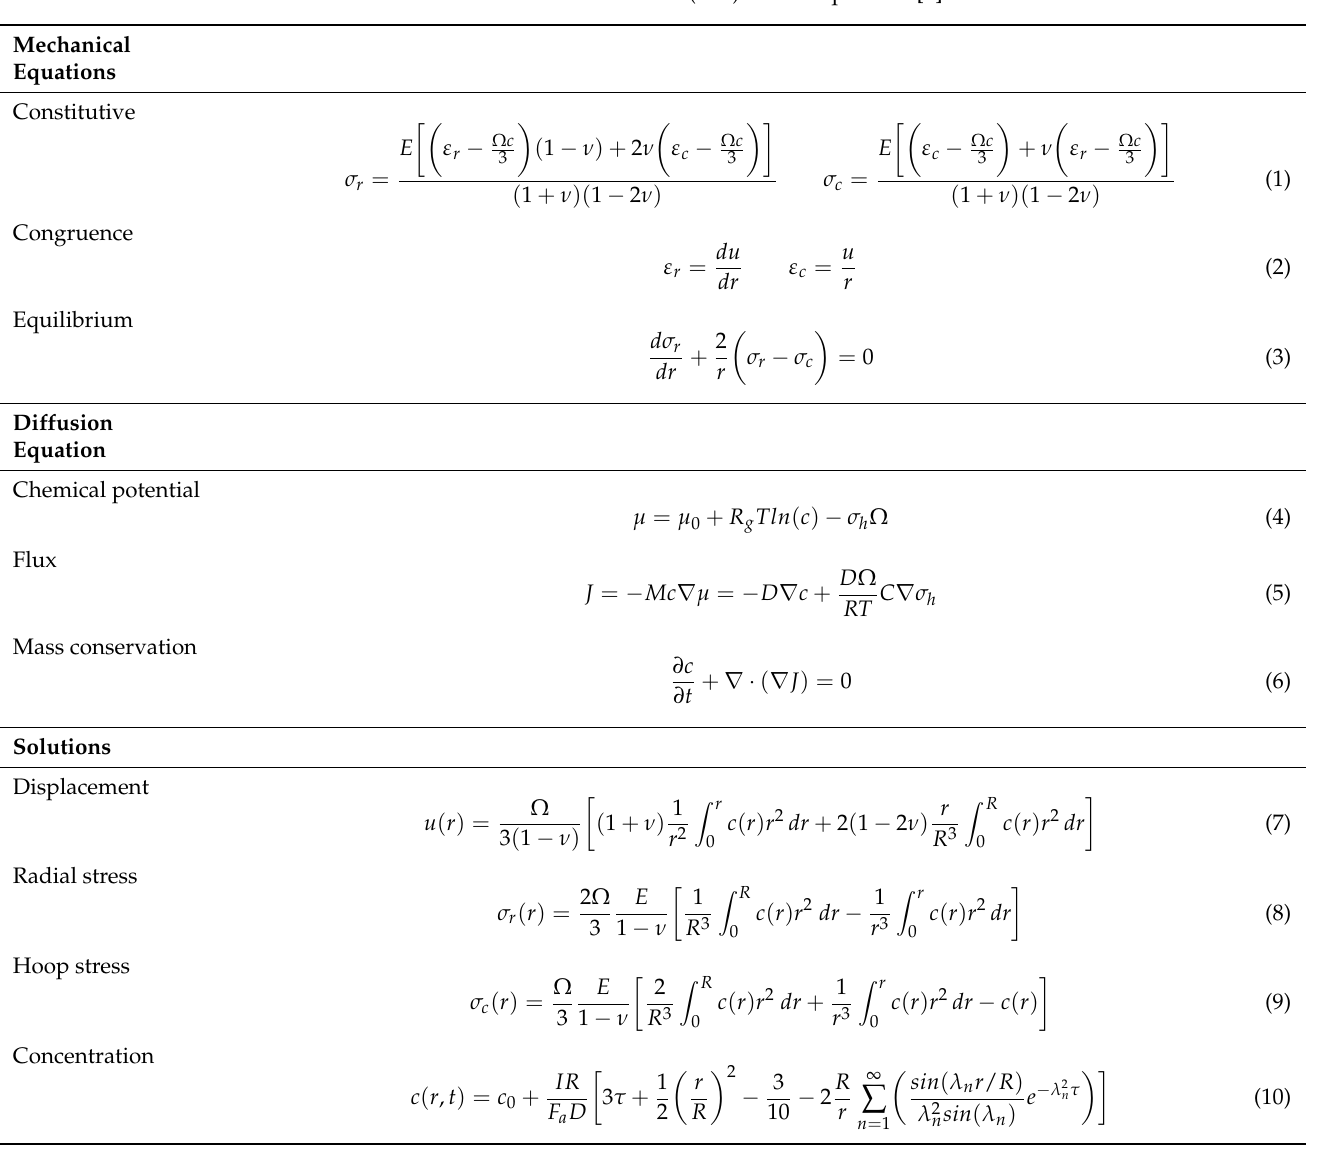
Table 1. Diffusion-induced stress (DIS) model equations